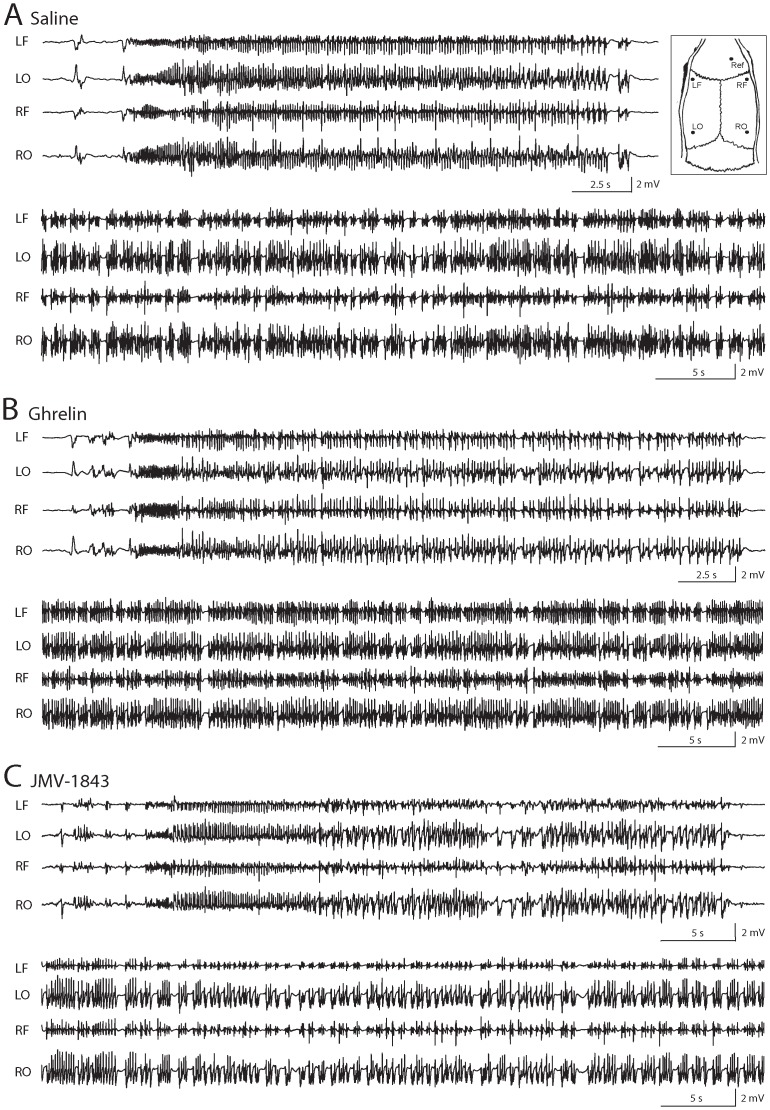
Electrocorticographyc (ECoG) activity in pilocarpine-treated rats.ECoG traces were obtained from 24 pilocarpine-treated rats, from left frontal (LF), left occipital (LO), right frontal (RF) and right occipital (RO) cortices (inset in A). Reference electrode (Ref) was in the frontal cortex. Representative ECoG traces of stage 5 seizures (upper traces) and of status epilepticus (SE) are recorded from pilocarpine-treated rats receiving saline (A), ghrelin (B) or JMV-1843 (C).